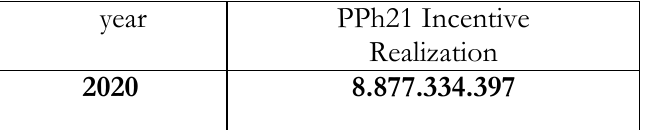
Table.2 Realization of PPh 21 Tax Incentives borne by the Government at KPP Pratama North